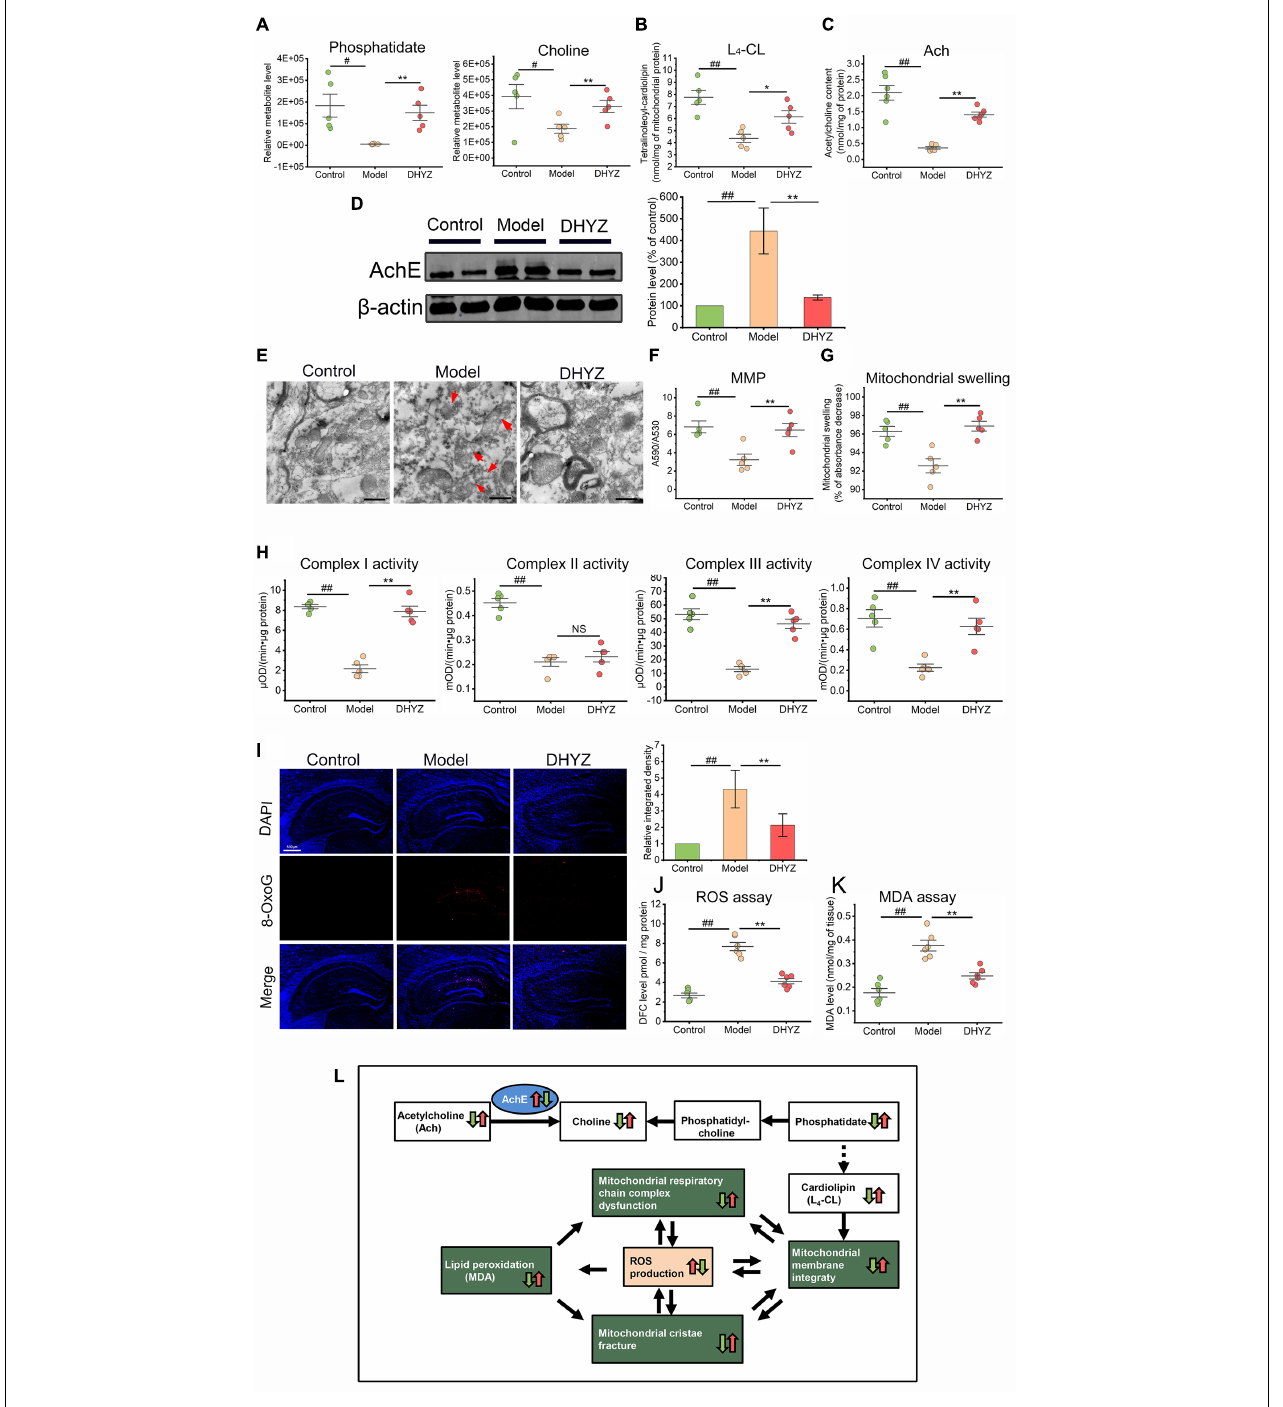
FIGURE 7 | The preservation effects of DHYZ on the glycerophospholipid metabolism and the structure and function of mitochondria. (A) Metabolomics analysis illustrating the relative levels of urine phosphatidate and choline. The level of L 4 -CL ( n = 5) (B) and Ach ( n = 6) (C) in the brain of 2 × Tg-AD mice were determined with LC-MS and fluorescence chemistry assay, respectively. (D) The AchE expression was detected by Western blotting ( n = 3). (E) Representative electron micrographs of hippocampal tissues of mice of the control, model, and DHYZ group. Red arrows denote the lesions of mitochondrial ultramicrostructure (magnification × 40 000, scale bar = 500 nm). MMP (F) and mitochondrial swelling (G) were measured to assess the integrity of the mitochondrial membrane. (H) The activities of respiratory chain complexes I, II, III, and IV were assessed to evaluate the mitochondrial function. (I) Representative images of immunofluorescence staining of 8-OxoG (red, Alexa Fluor R (cid:13) 594; blue, DAPI) and the corresponding histogram of 8-OxoG relative intensity in hippocampus regions